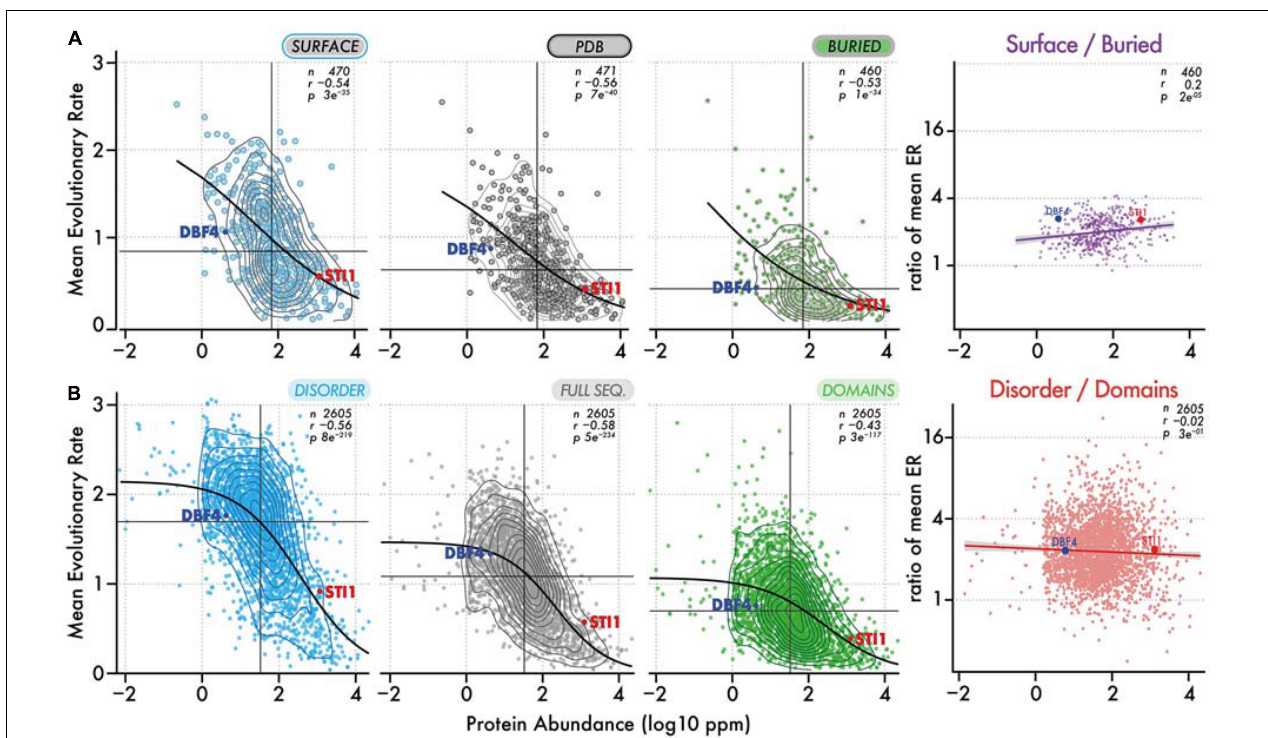
FIGURE 4 | Evolutionary rates of different regions and their ratio as a function of abundance. (A) Evolutionary rates ( y -axis) as a function of protein abundance ( x -axis) for surface regions, full-length structures, and buried regions. The ratio of evolutionary rate for surface vs buried regions is also shown as a function of abundance. Contour lines show the density of points. The median evolutionary rate and median protein abundance are shown by a vertical and horizontal line, respectively. The Spearman rank correlation coefficient and p -value are given with the number of proteins in each dataset. A black line shows the fitted sigmoidal regression for each plot. We highlight two proteins, one with a low and one with a high abundance (DBF4 and STI1). Both have comparable structural features but different evolutionary rates. (B) Same representation as in panel (A) , now considering disordered versus domain